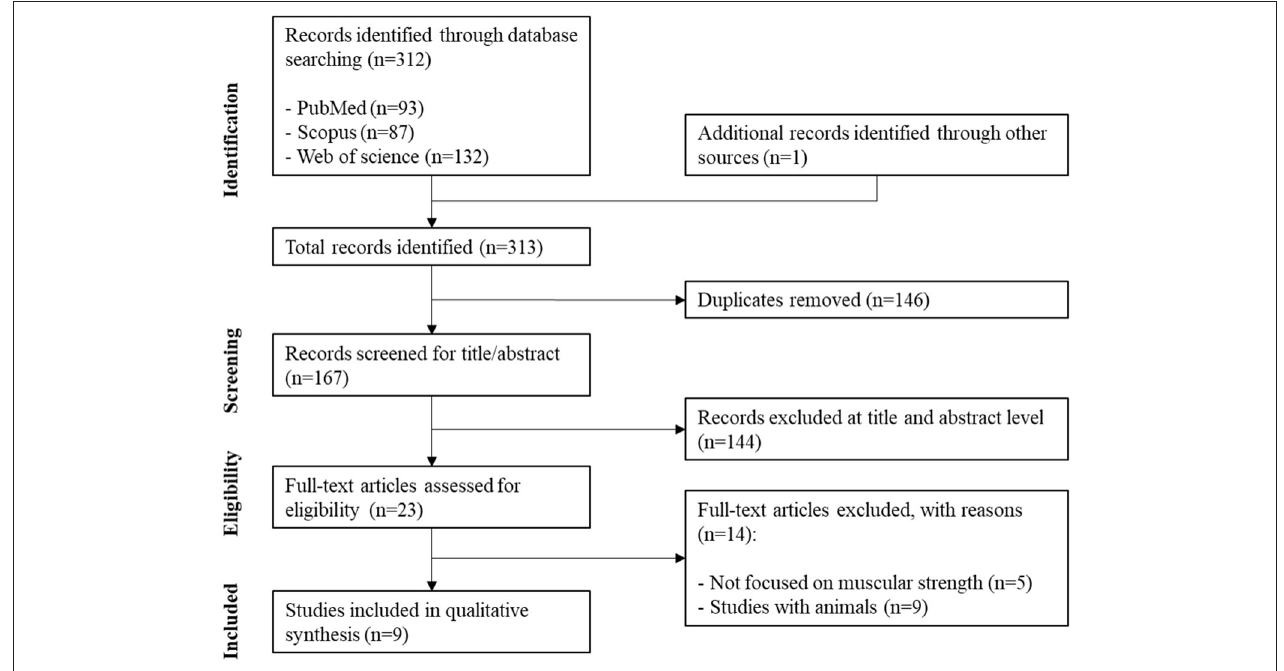
FIGURE 1 | Flow diagram of study